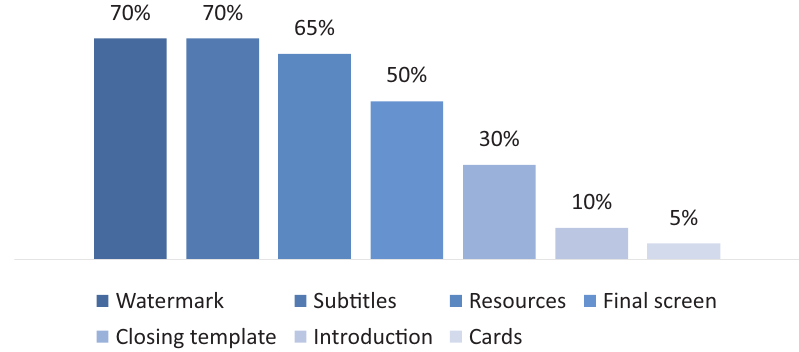
Figure 4. Post‐production aspects in videos of YouTubers from the Andean